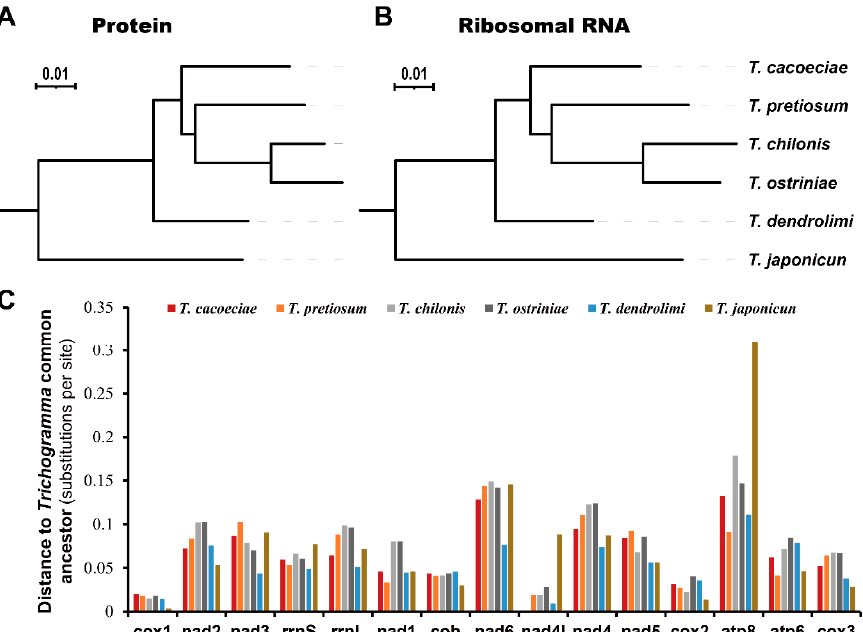
Figure 3. Comparison of substitution rates among Trichogramma species. Substitution rates were estimated using ( A ) concatenated 13 mitochondrial proteins or ( B ) concatenated two ribosomal RNAs. ( C ) Distances to Trichogramma common ancestor for individual mitochondrial proteins or ribosomal RNAs. Genes are ordered by their locations on mitochondrial genomes.